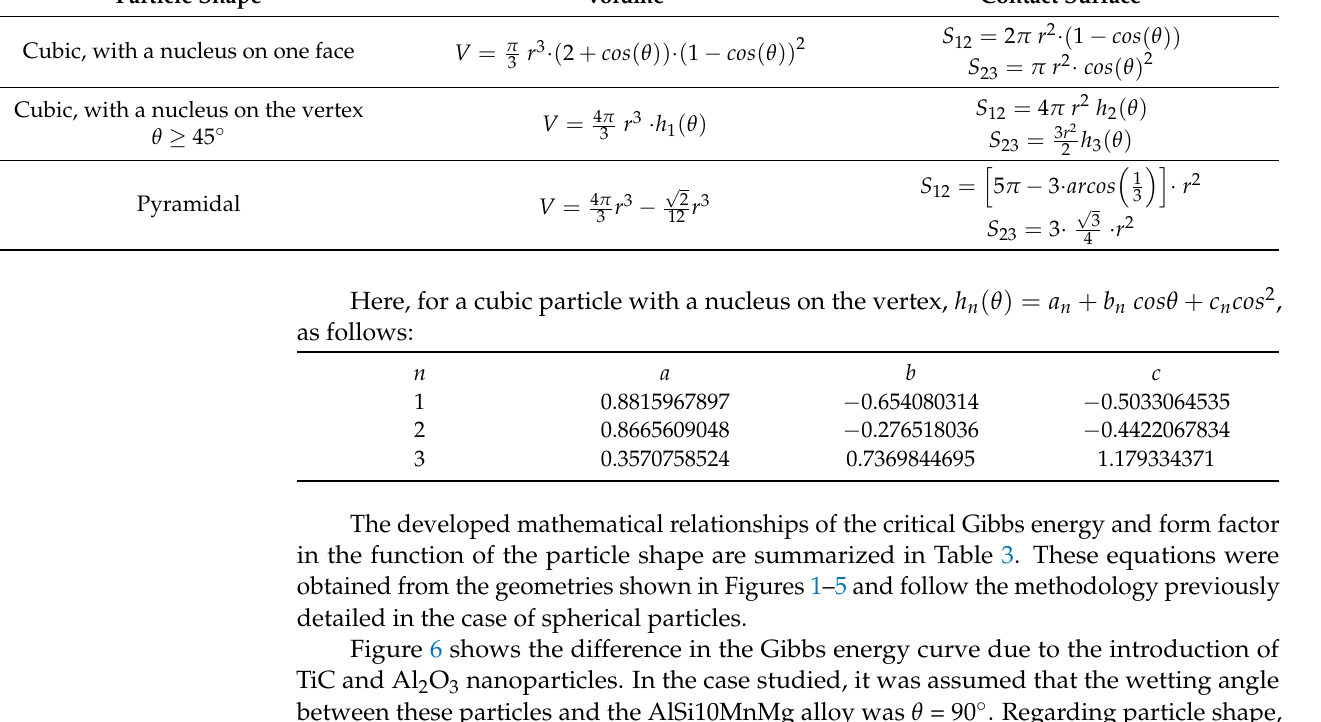
Table 2. Calculated volume and contact surface in the function of the particle shape.